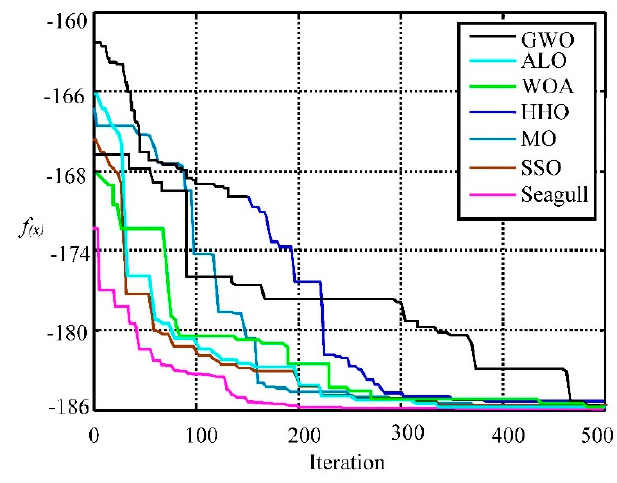
Figure 12. Convergence of proposed methods to solve the standard test function.